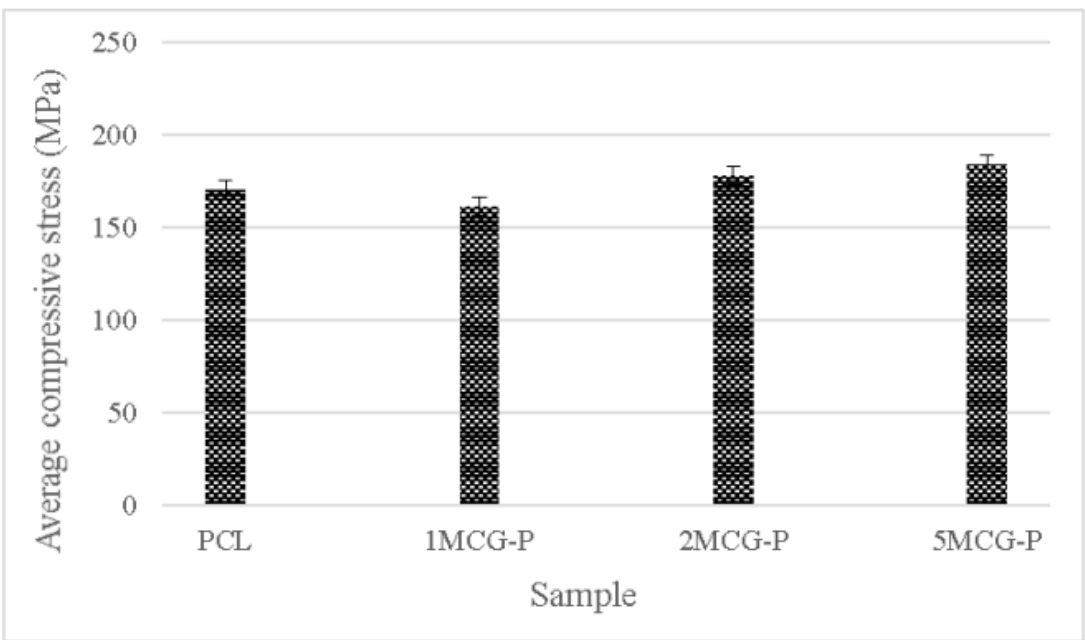
Figure 11. Compressive strength of CS/Gel/MMT/PCL bone scaffolds.